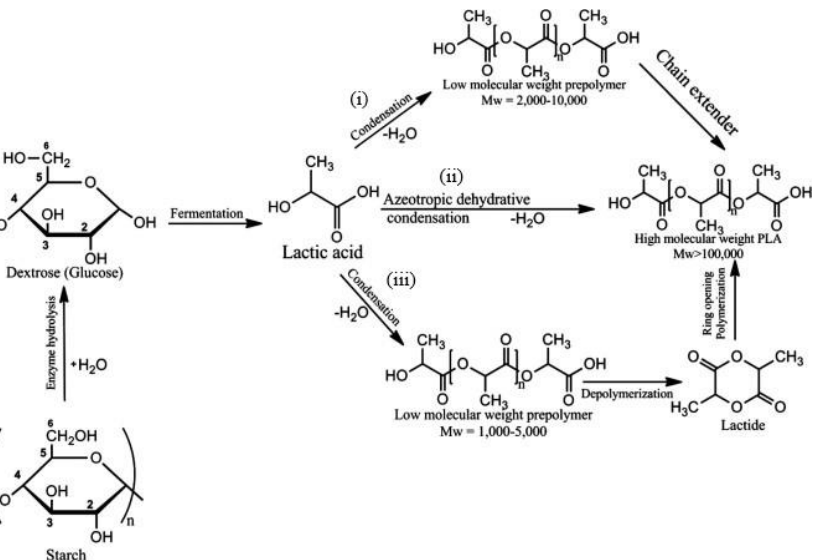
Figure 3. Fabrication routes of PLA. Reprinted with permission from Ref. [41]. Copyright 2015 Elsevier